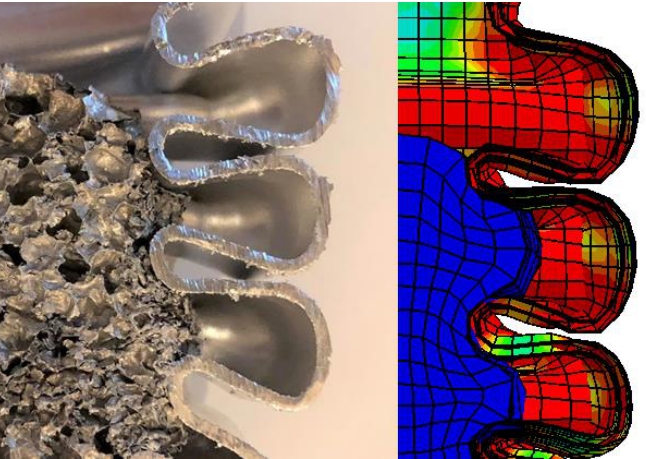
Figure 14. The shape of plastic hinges for a 60 mm long aluminum foam-filled specimen.